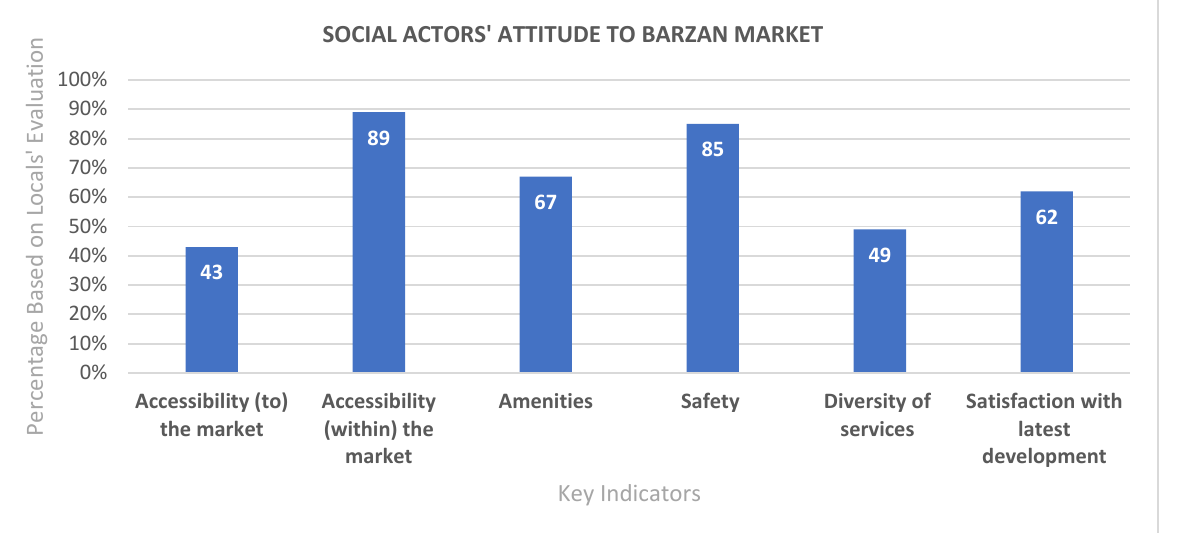
Figure 12. Social interaction assessment.